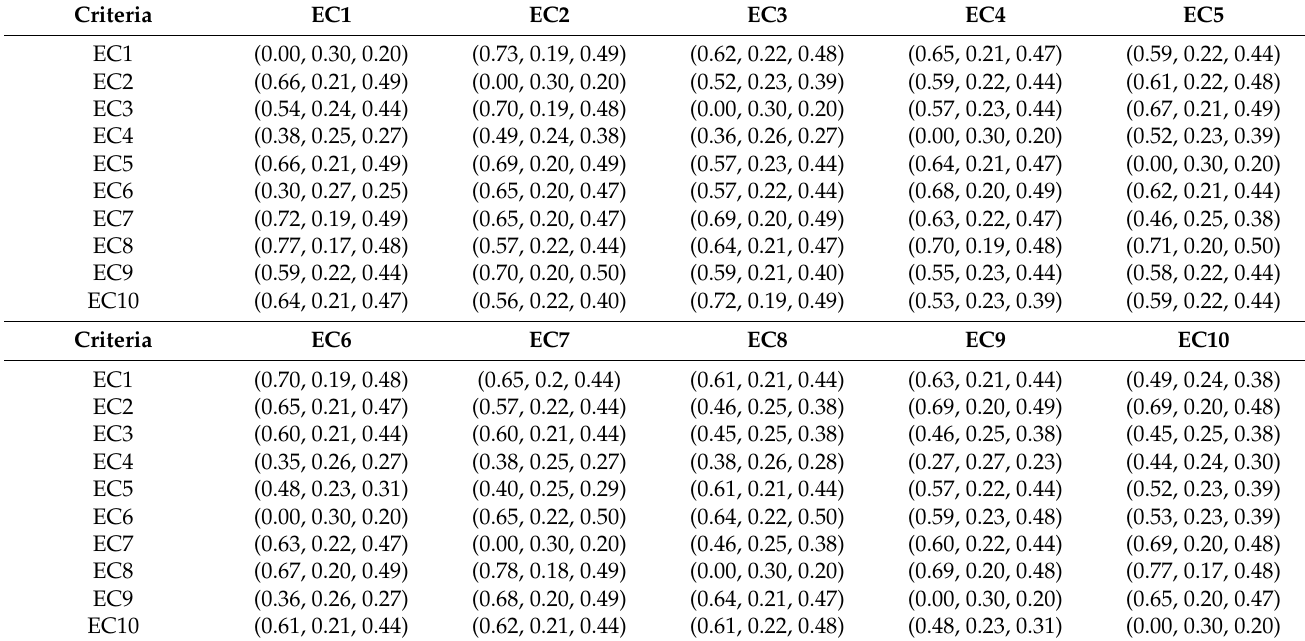
Table 6. Aggregated spherical fuzzy direct influence matrix.